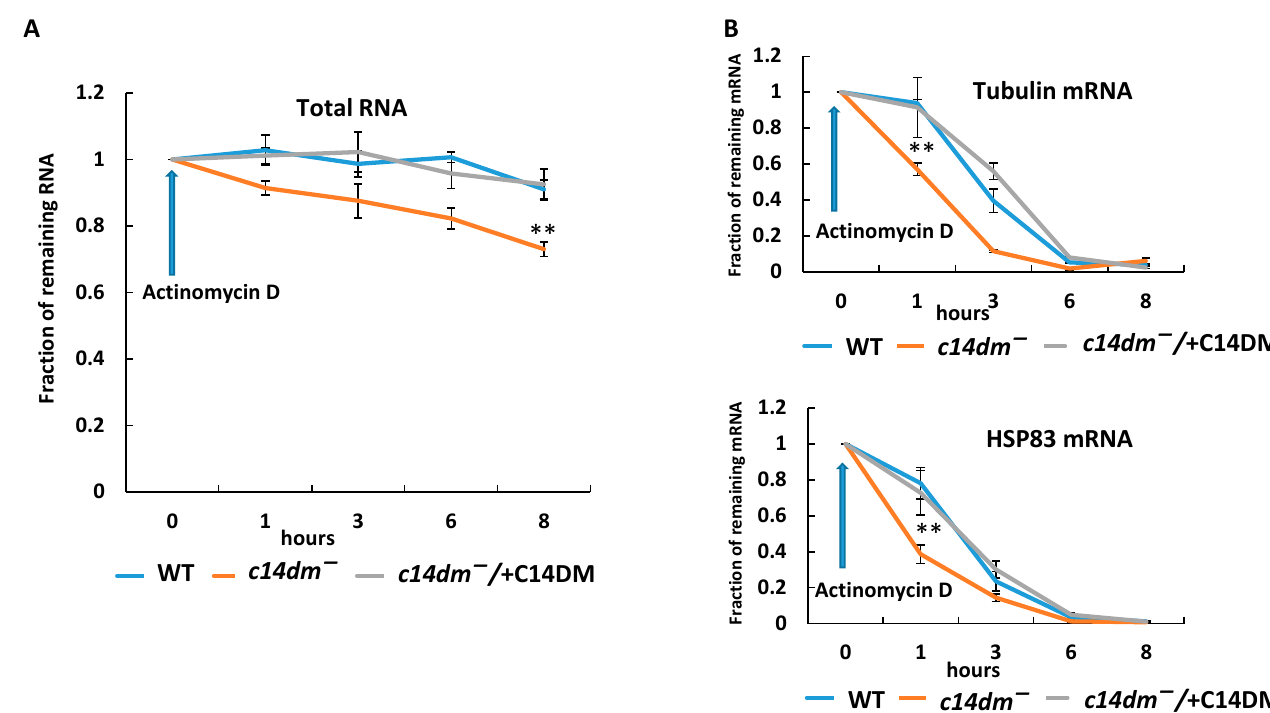
Figure 3. RNA in c14dm − degrades faster in comparison to WT and add-back parasites. Actinomycin D was added to mid-log cultures, and equal aliquots of cultures were taken at the indicated times. RNA was extracted and analyzed by RT-qPCR relative to the values at the starting point. ( A ) Total RNA was quantified using NanoDrop over time. ( B ) The relative abundance of tubulin and HSP83 mRNA was quantified by RT-qPCR over time. **: p < 0.01.